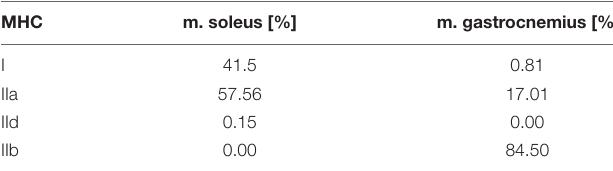
TABLE 2 | Myosin isoform percentages (MHC) in the soleus and gastrocnemius muscle, modified according to Augusto et al.